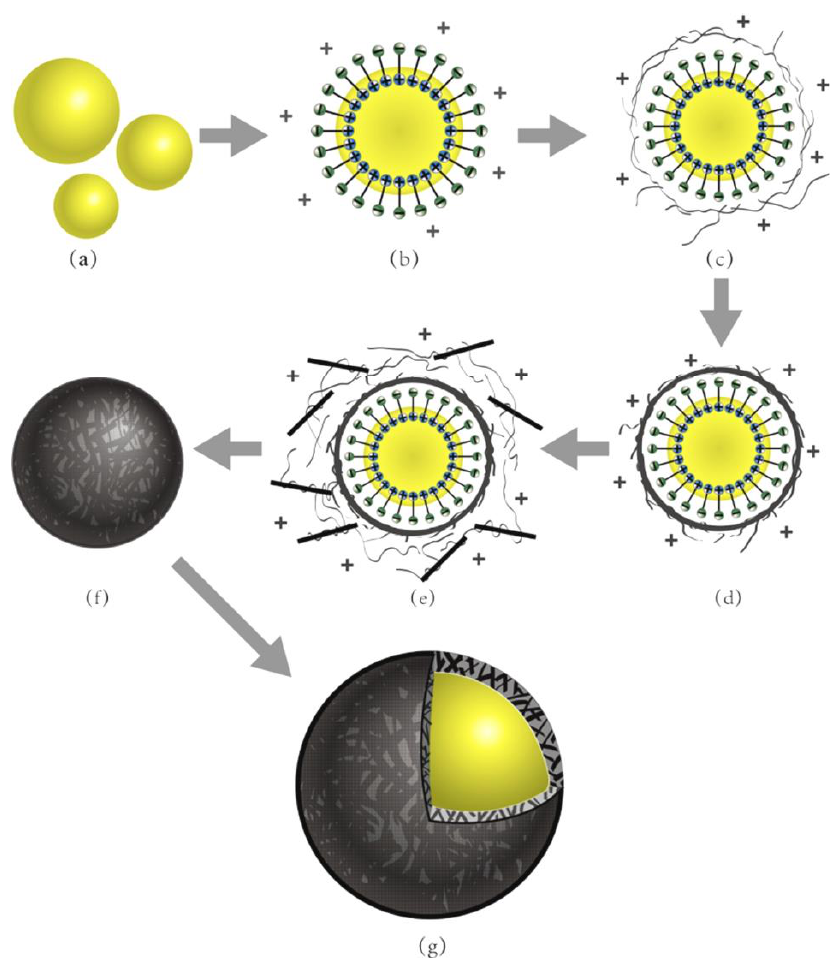
Figure 1. Illustration of self-healing microcapsules containing rejuvenator fabrication process by a two-step self-assembly method, ( a , b ) rejuvenator emulsified by SMA molecules, droplets with negative charge, ( c ) HMMM prepolymer added dropwise and attached to the surface of the droplets, droplets with positive charge, ( d ) the HMMM prepolymer cross-linked in the first step of the polymerization, ( e ) the mixture of HMMM prepolymer and graphene added dropwise, HMMM prepolymer and graphene absorbed on core droplets by charge, ( f ) microcapsules formed through a second step polymerization process, and ( g ) a three-dimensional anatomical structure of one self-healing microcapsule with a graphene/HMMM shell.